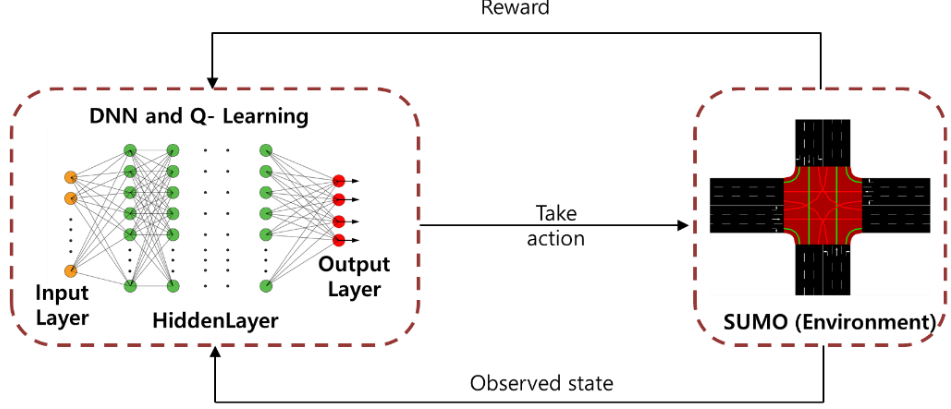
Figure 6. Q-learning with DNN.